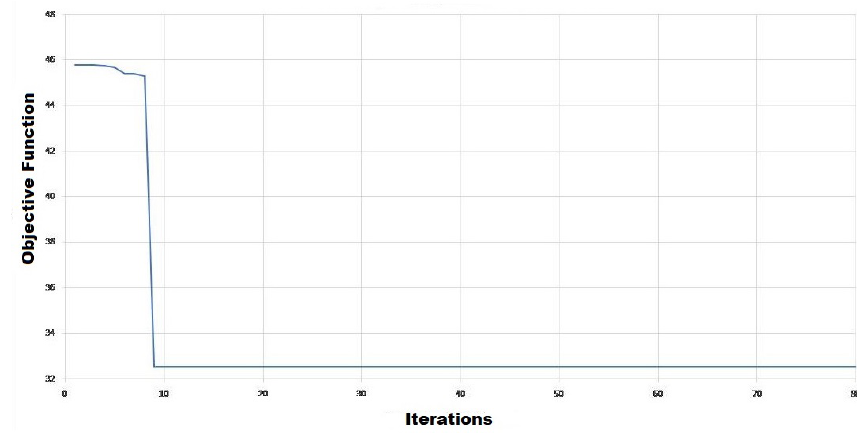
Figure 6. Objetive function 3 machine-9 bus system.